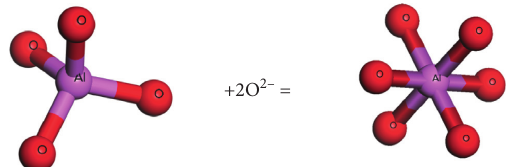
Figure 10: Schematic diagram for the changes of the [AlO